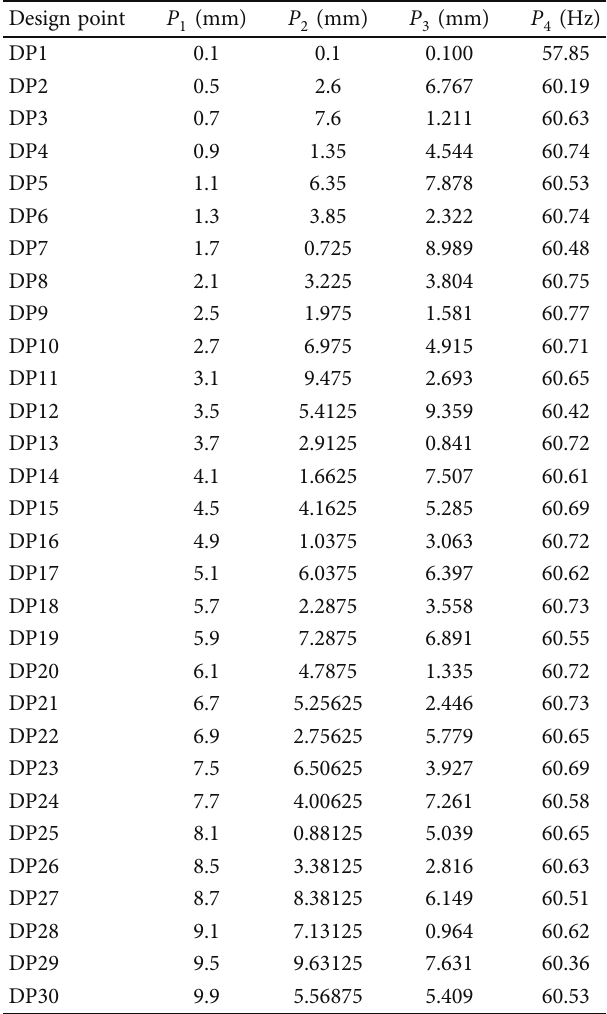
Table 3: Calculation results of di ff erent design variables. Design point